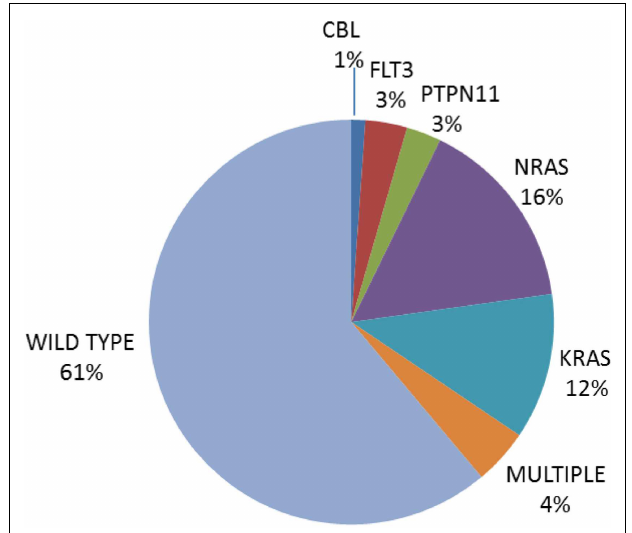
FIGURE 3 | Pie chart of the frequency of Ras pathway mutations in an unselected cohort of 180 UK diagnosticALL [data from Ref. ( 15, 48)].